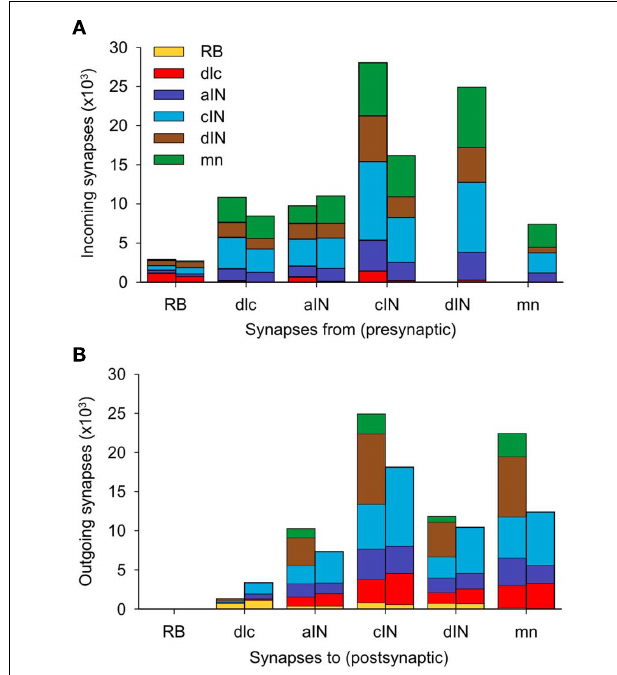
FIGURE 7 | Distribution of synapses in a single connectome model. (A) For each neuron type, the two stacked columns show outgoing synapses onto all other neuron types; post-synaptic neuron types (color coded as in Figure 1A ) receive incoming synapses from descending axons (right columns) and ascending axons (left columns). (B) Like (A) , but each stacked column shows the distribution of incoming synapses from all other cell-types, made via descending axons (left columns) and ascending axons (right columns). See Table 2 for data.